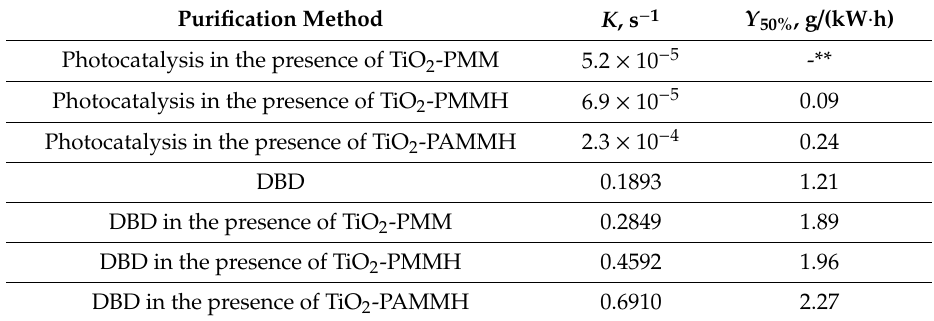
Table 2. E ff ective rate constants K and energetic e ffi ciency Y 50% for the process of Rhodamine B